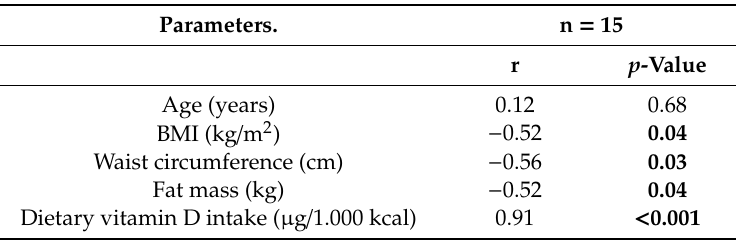
Table 2. Correlations among 25OHD levels with age, anthropometric measurements, fat mass, and dietary vitamin D intake. Parameters.